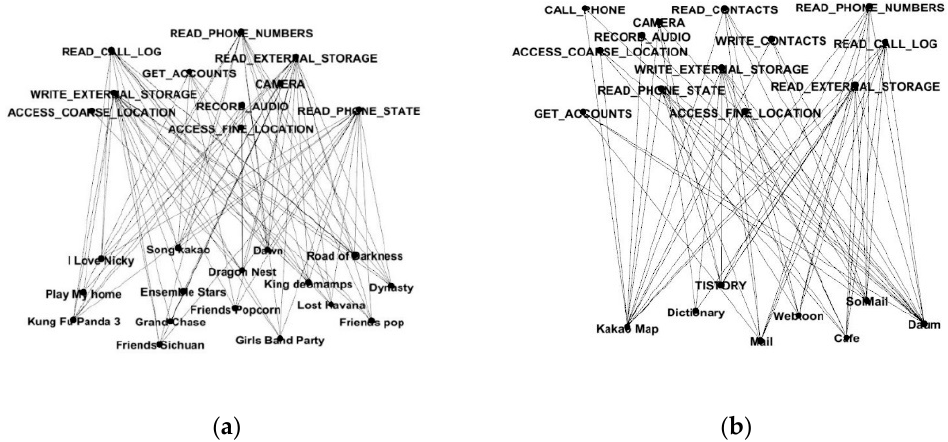
Figure 7. Applications require permissions (owner: Kakao). ( a ) Kakao Games Corp. and ( b ) Daum